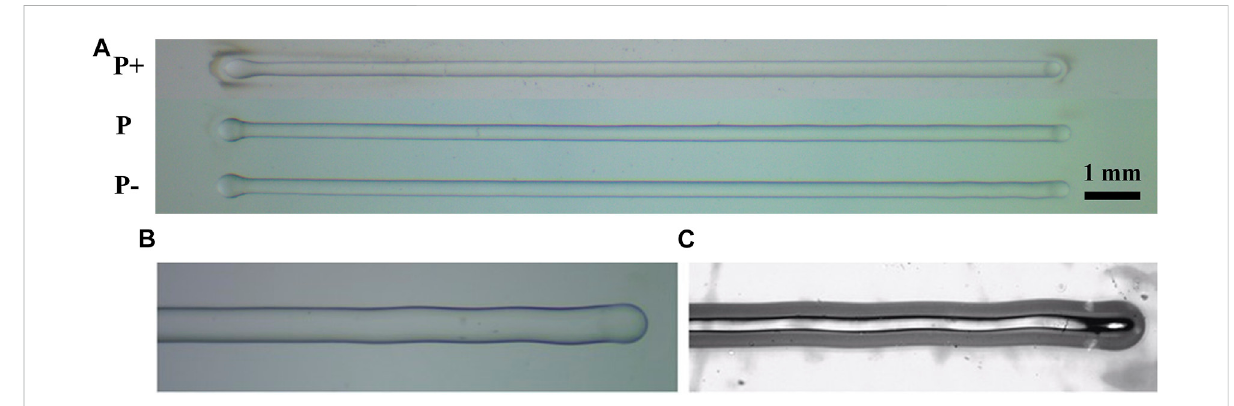
FIGURE 2 Microscope images of lines printed at 60 mm/min (A) when using (P+) too much laser power showing fumed silica deposits (P) suitable laser power,and(P-)usingtoolowlaserpowershowingwiggling.Notethewigglyphenomenonismoreobvioustowardstheendduetotheaccumulated instability during the line printing. Magni fi ed images of wiggles are shown when viewed from top (B) and from bottom (C) , through the substrate.